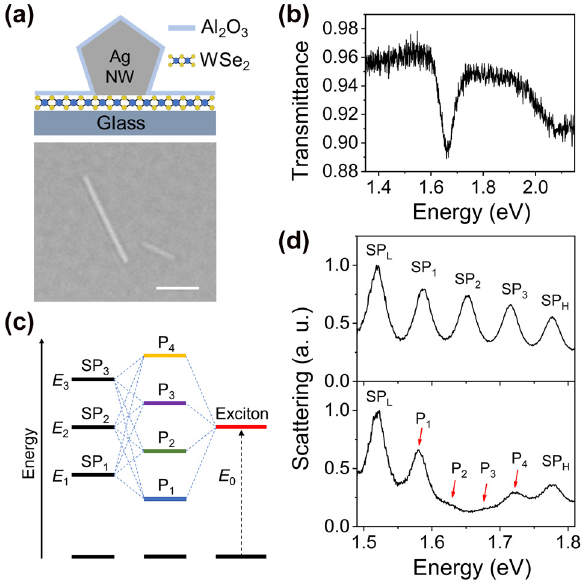
Figure 1: Schematics and characterizations of Ag NW-WSe coupled 2 system. (a) Schematic of the cross section (top) and optical microscopy . The scale bar is 2 μ m. image (bottom) of a Ag NW on monolayer WSe 2 monolayer on glass substrate. (b) Transmission spectrum of a WSe 2 (c) Schematic representation of the strong coupling between three plasmon modes and one exciton state resulting in four plexciton states. (d) Scattering spectra of Ag NWs without (top) and with (bottom) . The plexciton peaks are marked with red monolayer WSe 2